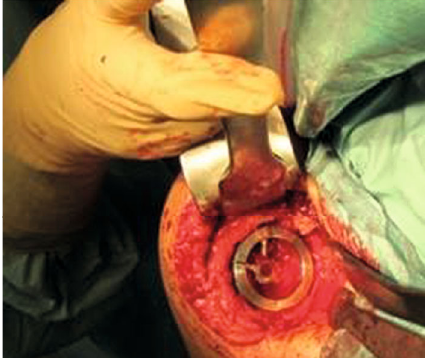
Figure 3: Seated core of the SMR.